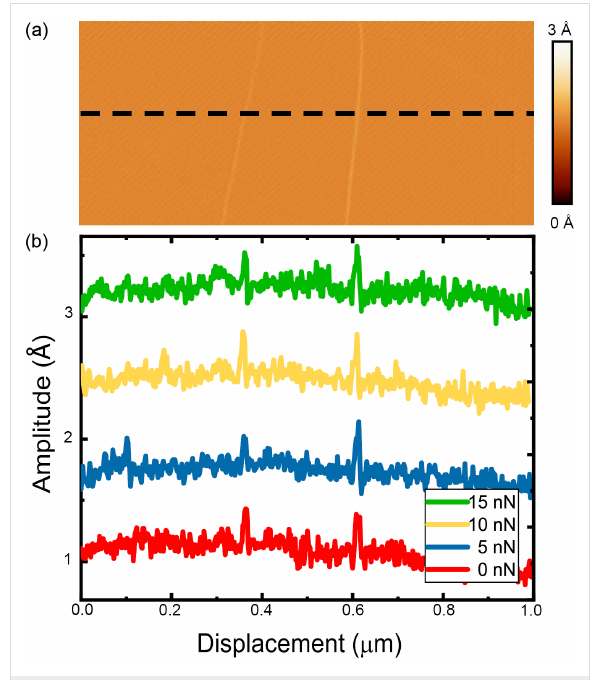
Figure 8: (a) Amplitude map obtained while the tip traversed two single-height uncovered atomic steps on an HOPG surface in FMM (modulation frequency = 1.5 kHz). (b) Amplitude line profiles acquired along the black dashed line in (a). The normal force was increased from 0 nN (red), 5 nN (blue), 10 nN (yellow), and 15 nN (green) while recording the amplitude variation of the cantilever. Each line profile has been offset by a value of 1 Ångström to make identification of the amplitude variation over the uncovered step clear. The data presented in this figure were acquired with tip